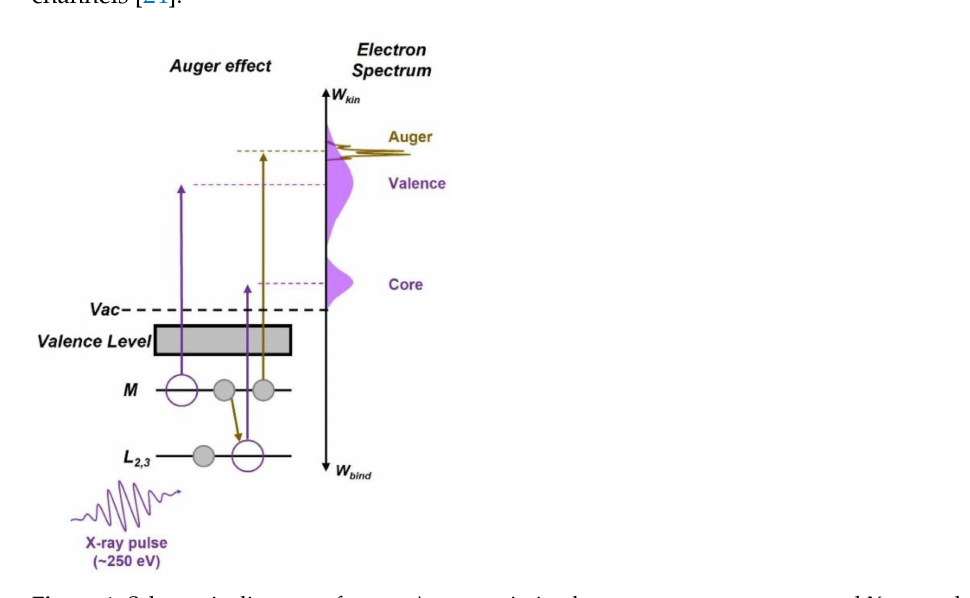
Figure 1. Schematic diagram of argon Auger emission by exposure to an attosecond X-ray